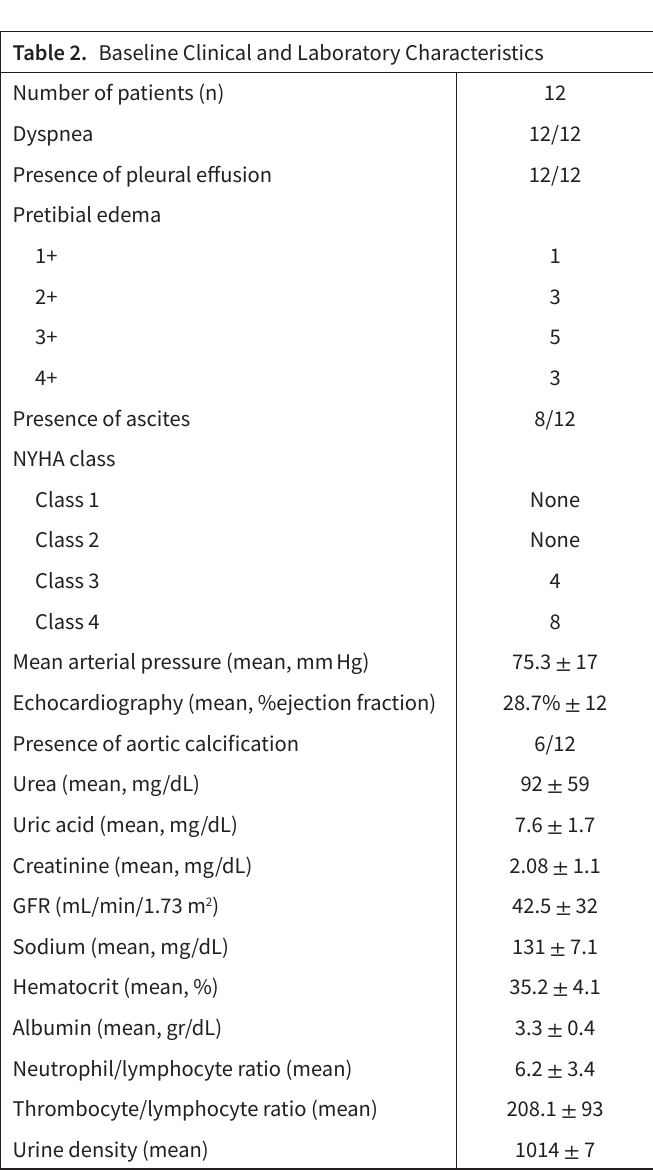
Figure 1. Overall survival among patients with heart failure that underwent peritoneal